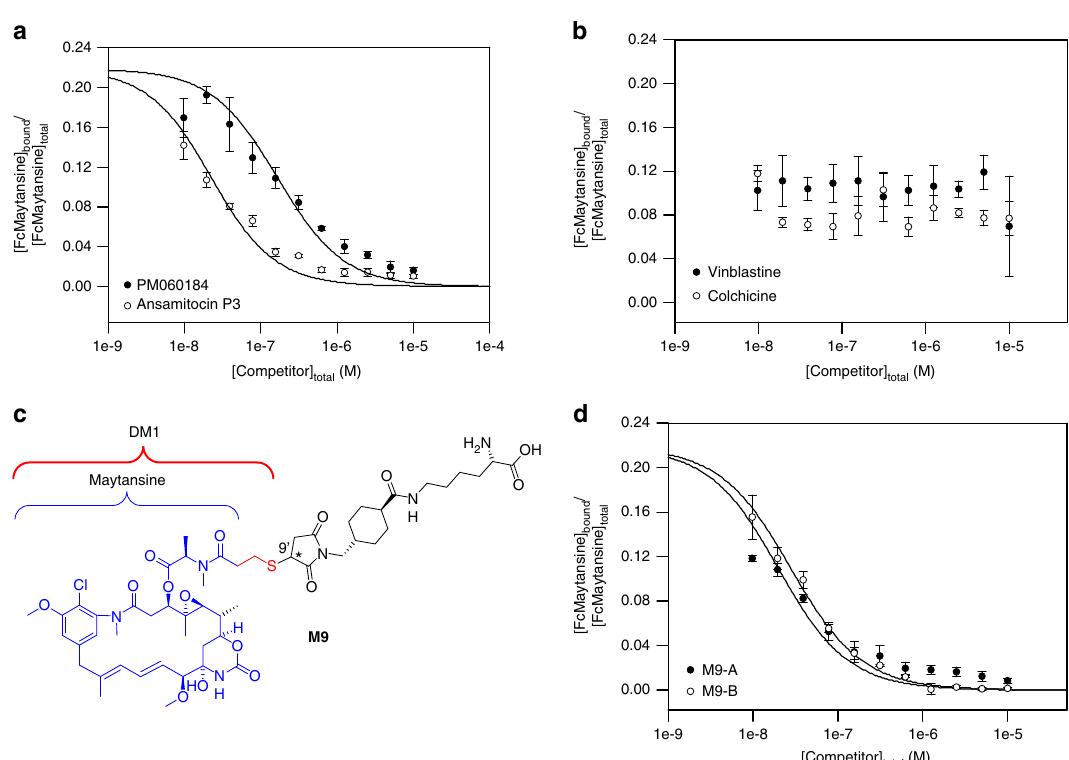
Fig. 3 Characterization of maytansine-site ligands. a , b Displacement assays for PM060184 (open circles) and ansamitocin P3 (closed circles) ( a ), and for vinblastine (closed circles) and colchicine (open circles) ( b ). c Molecular structure of the trastuzumab emtansine derivative M9 . d Displacement assays for the two diastereoisomers of M9 , M9A (closed circles) and M9B (open circles). The data are from three independent experiments and represent mean ± SEM. The solid lines represent fi ts to the data (see